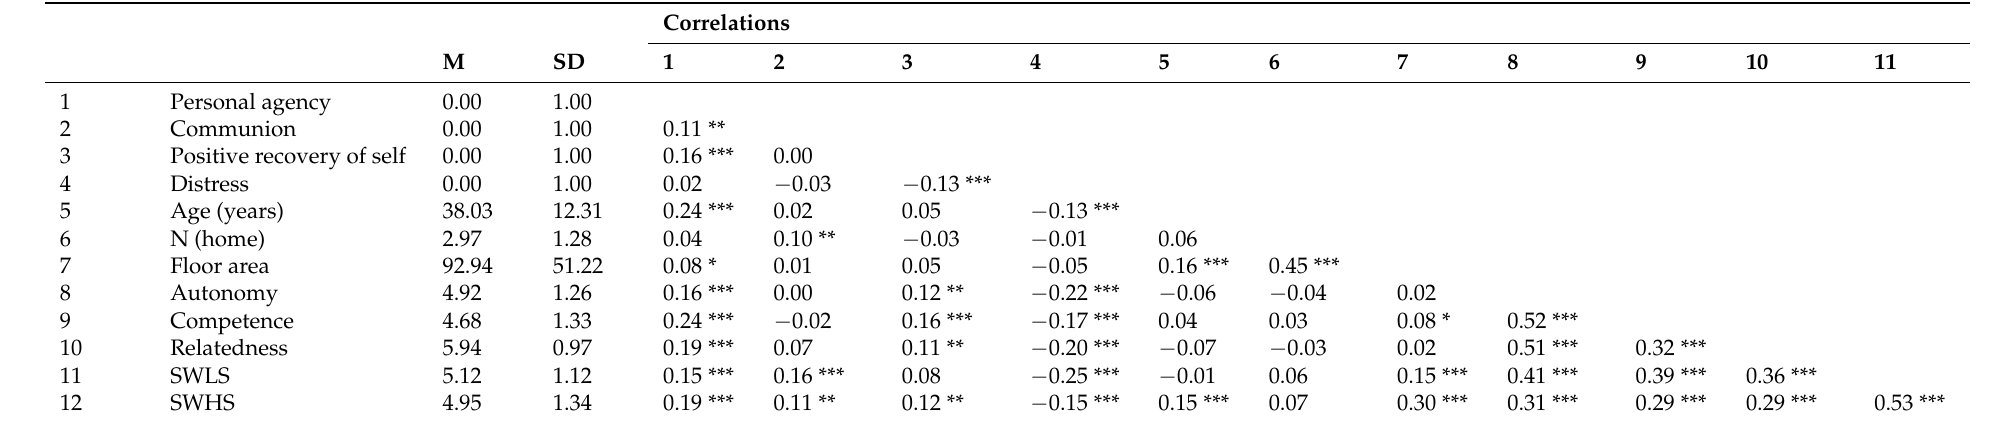
Table 2. Bivariate associations between study